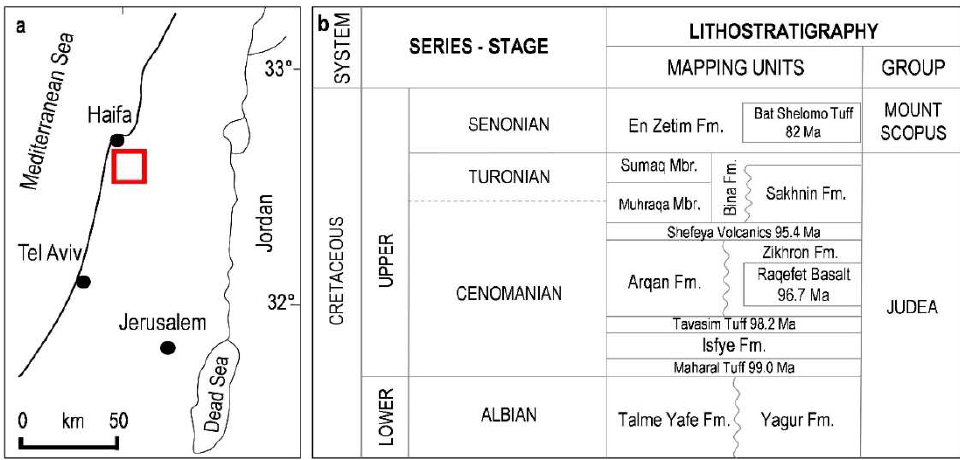
Figure 1. Study site. ( a )—location map, red square marks Mt. Carmel; ( b )—lithostratigraphy of Mt. Carmel and mapping units mentioned in the text (modified after [29]). Mbr: Member, Fm: Formation